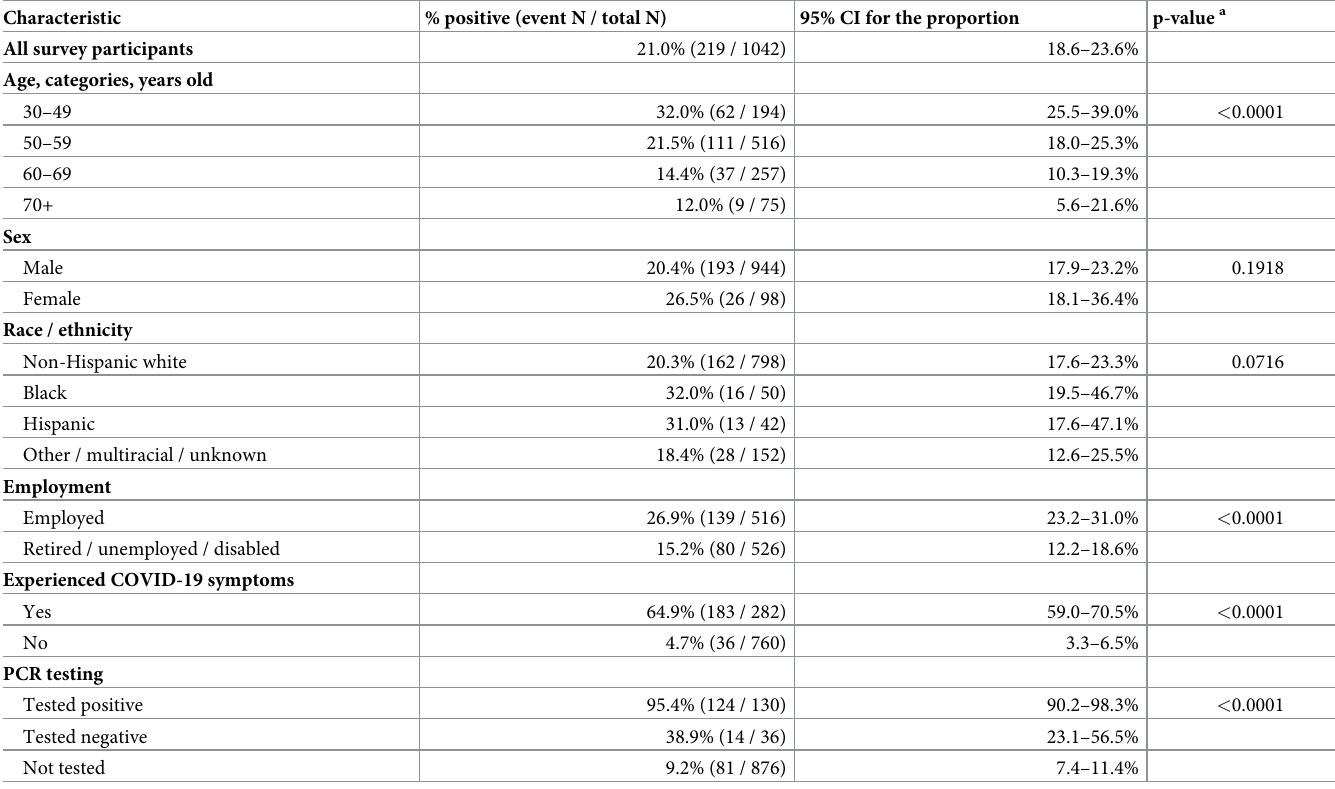
Table 2. Proportion of the seroprevalence survey participants (N = 1,042) testing positive for IgG antibodies to SARS-CoV-2.